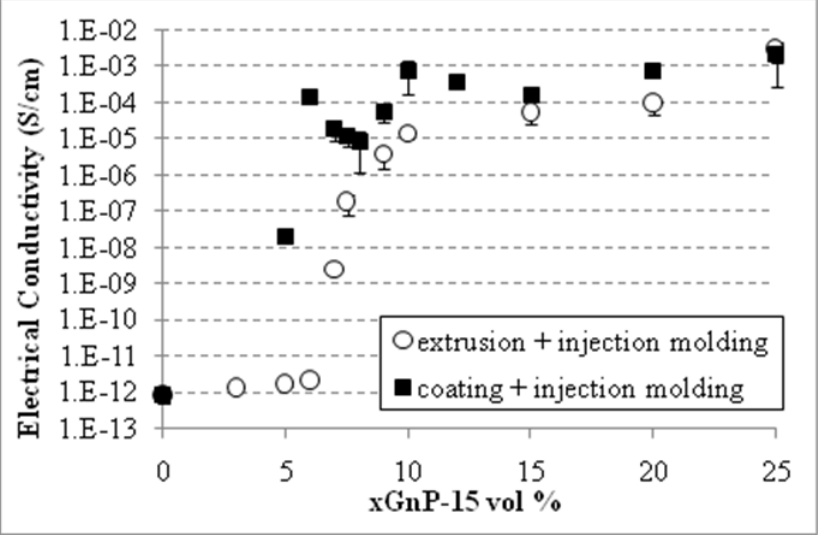
Figure 10. Effect of compounding on the percolation threshold and conductivity of xGnP- 15-PP made by injection